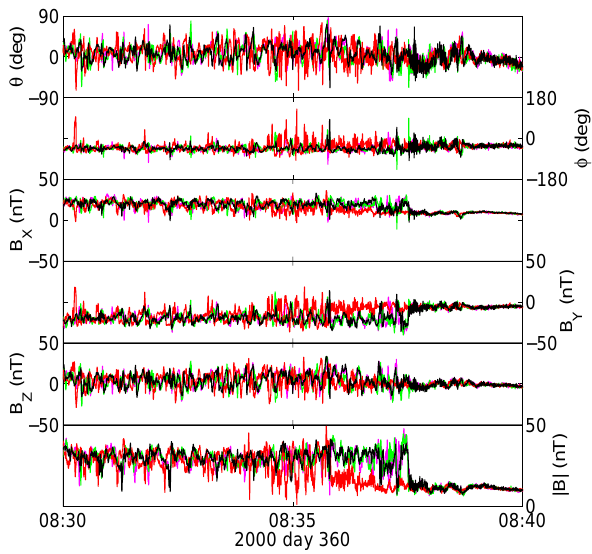
Fig. 10. Four spacecraft magnetic field data showing quasi-periodic oscillations in the magnetosheath and around the bowshock, in the same format as Fig.